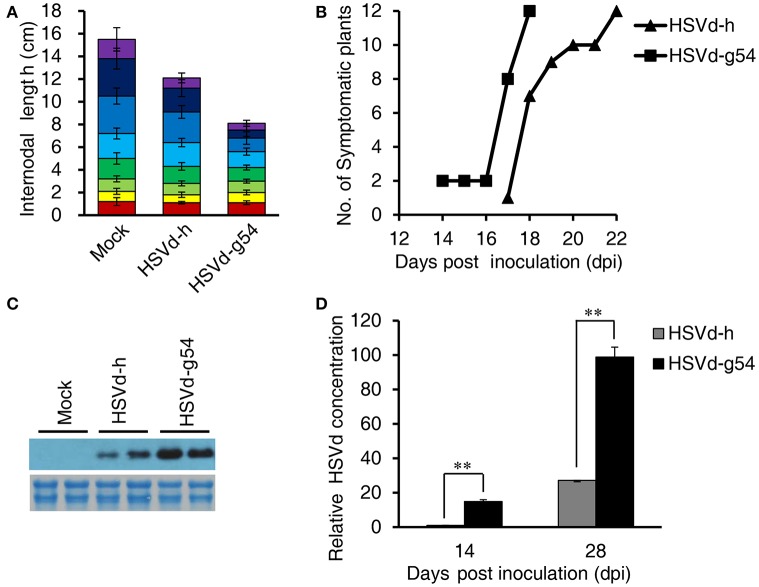
Effect of HSVd-h and HSVd-g54 infection on cucumber growth and development. (A) Internode lengths of cucumber plants at 28 dpi. Individual colored bars represent the lengths of successive internodes, with the first internode shown at the bottom. Measurements were taken from 12 cucumber plants per treatment, and data are expressed as the mean ± standard deviation. Error bars indicate the standard deviations of 12 replicates. (B) Time course of symptom appearance in cucumber plants following viroid inoculation. (C) Comparison of the concentrations of the two HSVd variants at 28 dpi by Northern blotting. Total RNAs (2 μg) were fractionated by electrophoresis in 1.5% (w/v) agarose gels and used for loading controls (below the hybridization signals). (D) Relative levels of viroid RNA as determined by RT-qPCR. Experiments were performed in triplicate and the data are expressed as the mean ± standard deviation. Error bars indicate the standard deviations of three biological replicates of RT-qPCR analysis. Double asterisks indicate statistically significant differences compared with the control at p < 0.01 in Student's t-test.